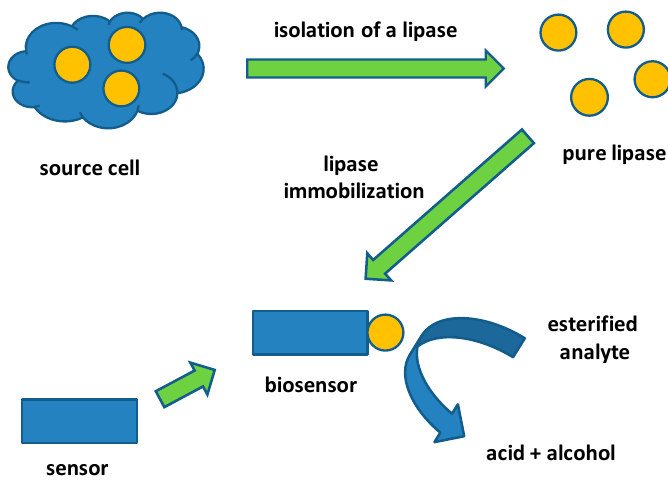
Figure 1. A general idea of a lipase biosensor construction.